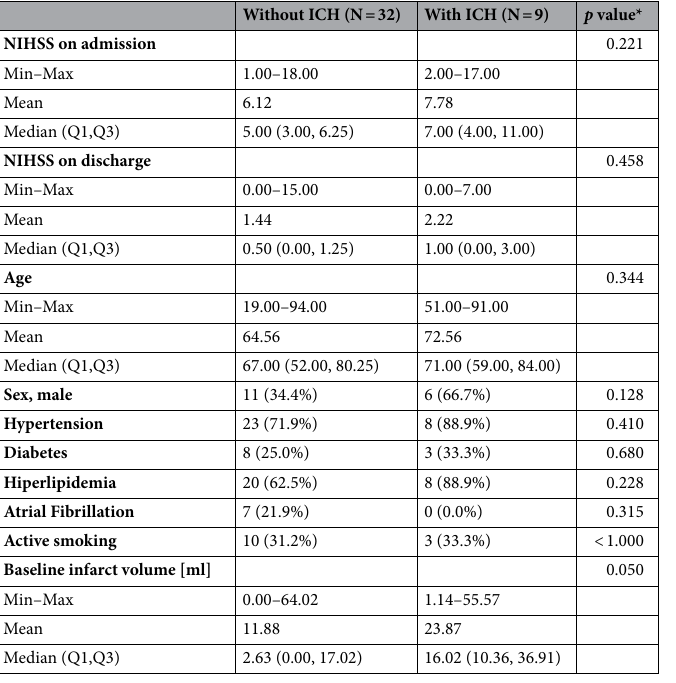
Table 2. Basic clinical and neuroimaging characteristics of ischemic stroke patients with and without intracranial hemorrhage after rtPA treatment. ICH—intracranial hemorrhage, NIHSS—National Institute of Health Stroke Scale; Q1—the first quartile; Q3—the third quartile; *Mann–Whitney U test was applied for comparison of quantitative data, whereas Fisher’s exact test was used to compare binomial data; p value equal or less than 0.05 was considered statistically